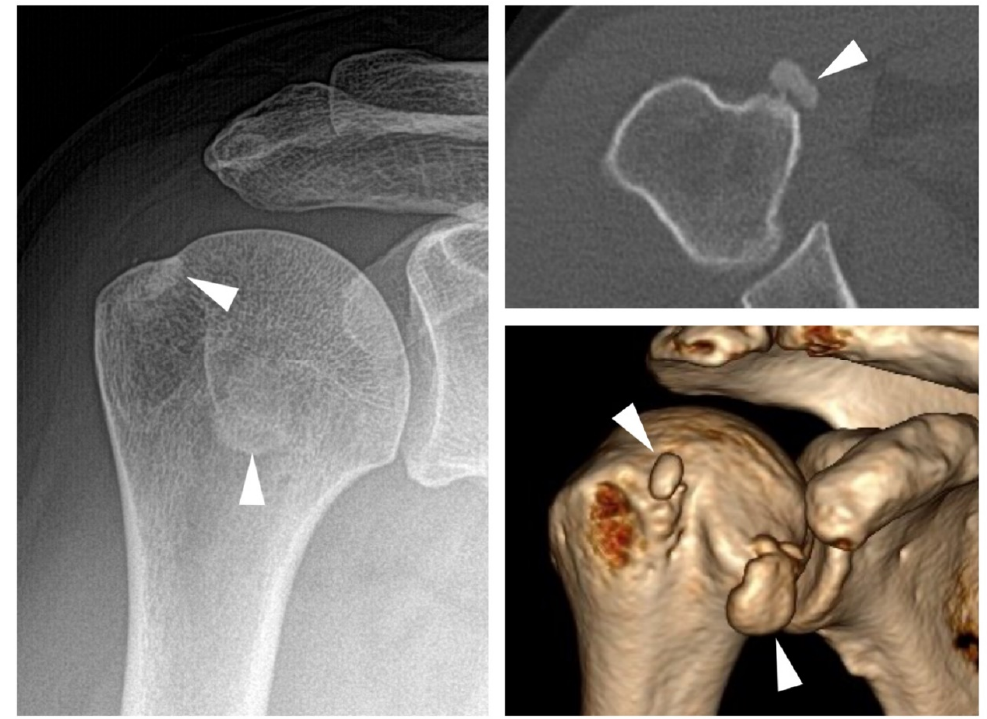
Figure 4. BCP deposition. ( Left ): White arrowheads indicate calcific deposition on radiography. ( Right ): Axial and 3D reconstructions of the same shoulder with better visualization of the depositions.